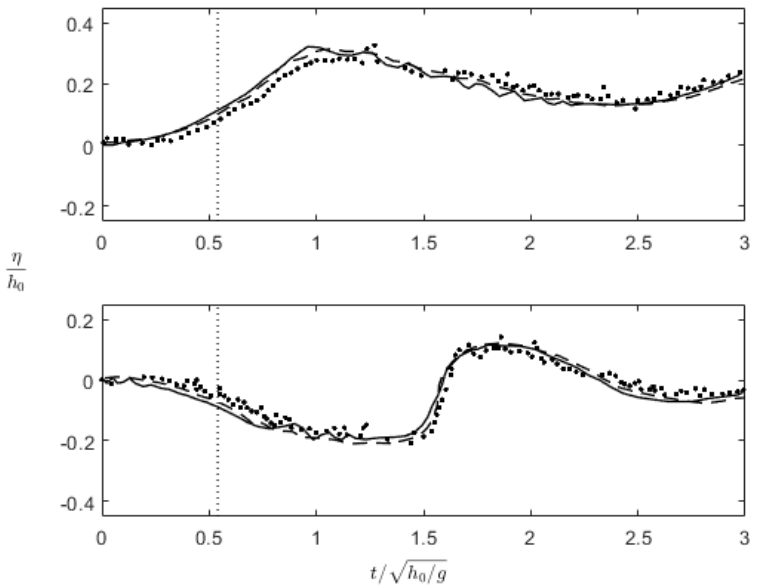
Figure 3. Records of free-surface elevation measured at the hinge. Top: leading elevation wave due to the upward bottom motion given in (1). Bottom: leading depression wave due to the imposed bottom motion by (2). Our solutions (solid lines) are compared with both numerical (dased lines) and laboratory (dots) results reported by Lu, Park, and Cho [37]. Vertical dotted line indicates the duration (cid:112) gh 0 ) = 0.54. In both cases, L = 1 m, h 0 = 0.03 m, a = 0.02 cm, b = 1 s, of bottom motion, b / ( L / and θ = 2.86 ◦ (1:20